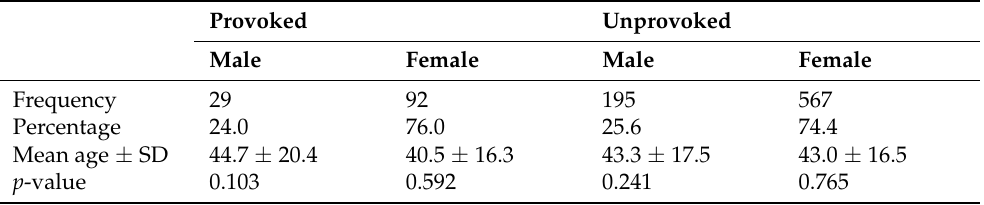
Table 1. Cases of provoked versus unprovoked